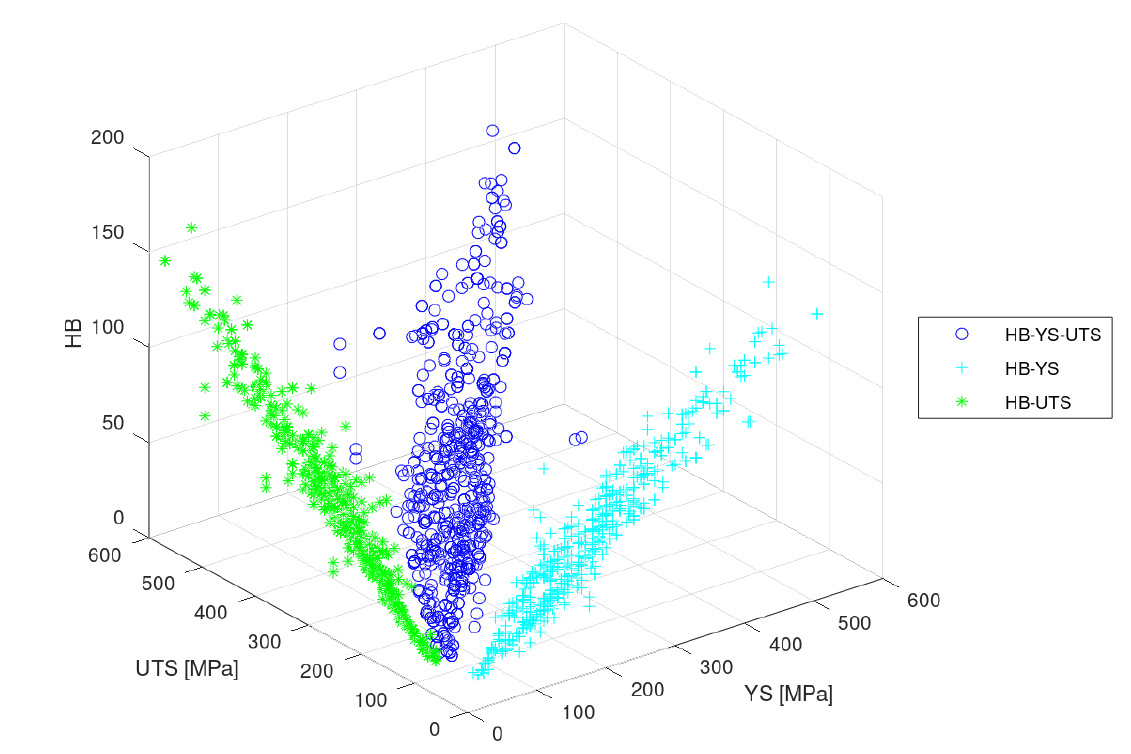
Figure 5. Scatter plot of the input dataset showing the relation